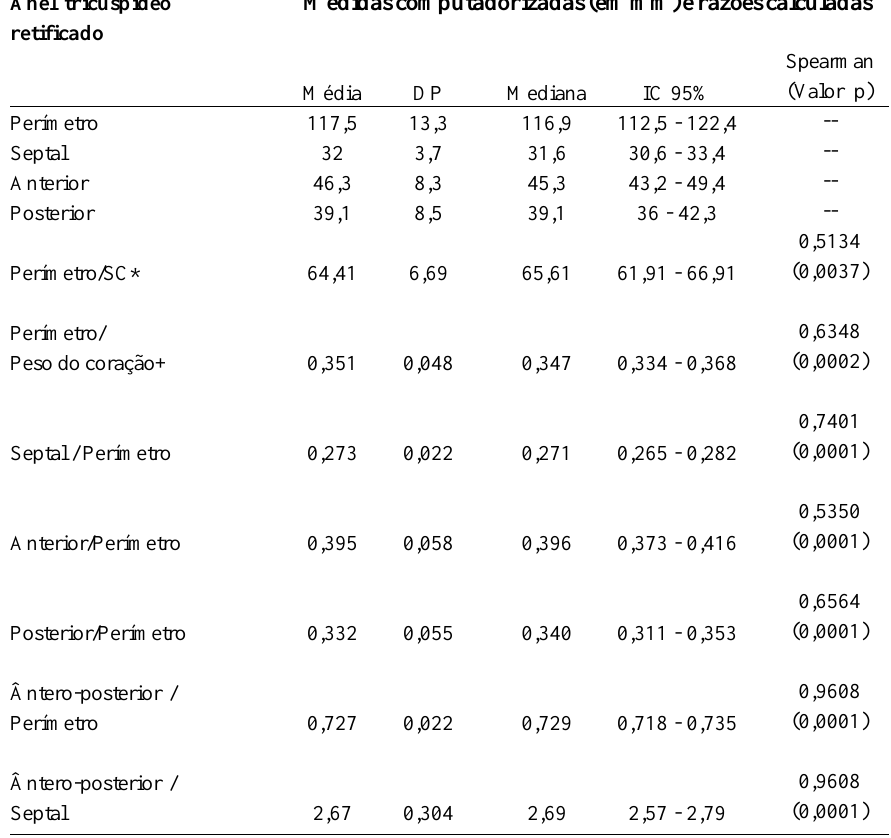
Tabela 2. Medidas e razões calculadas com anel tricuspídeo retificado.